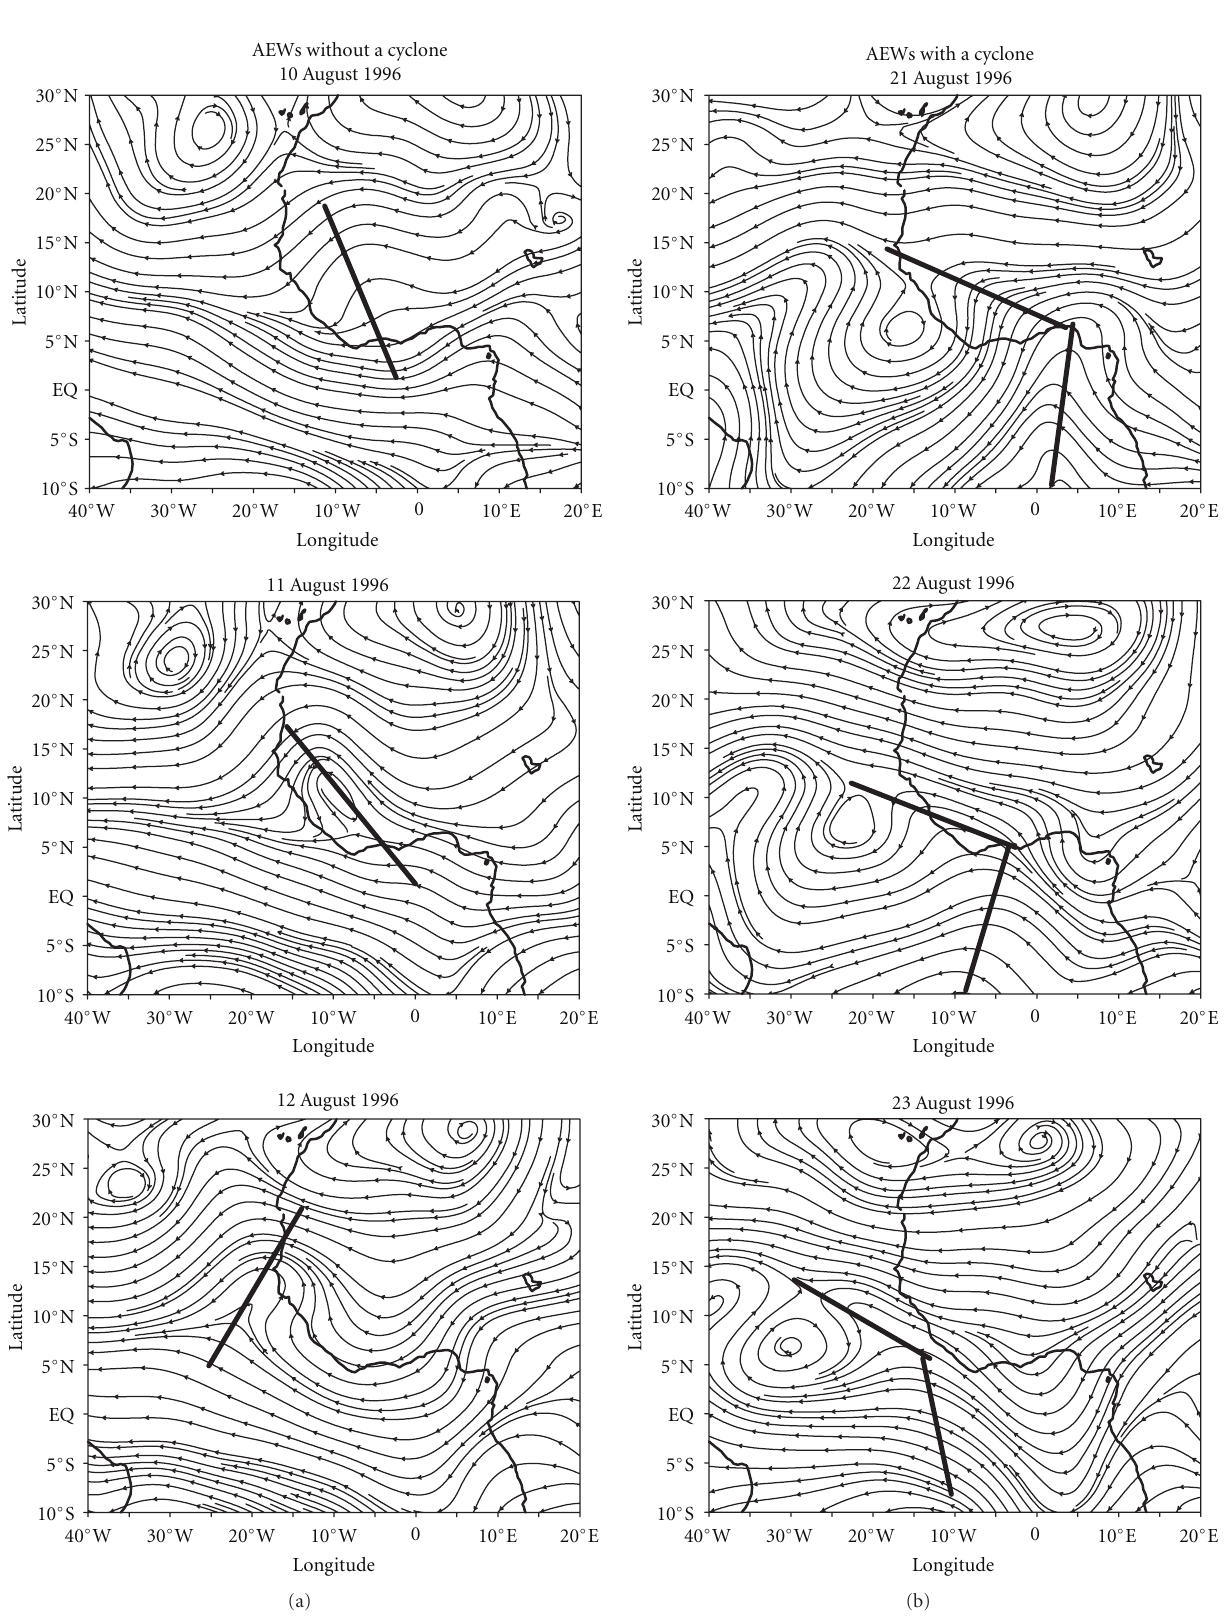
Figure 9: Streamlines of the 700 hPa wind for (a) the non-developing AEW (10–12 August 1996) and for (b) the AEW associated with a cyclone (21–23 August 1996). The line represents the location of the